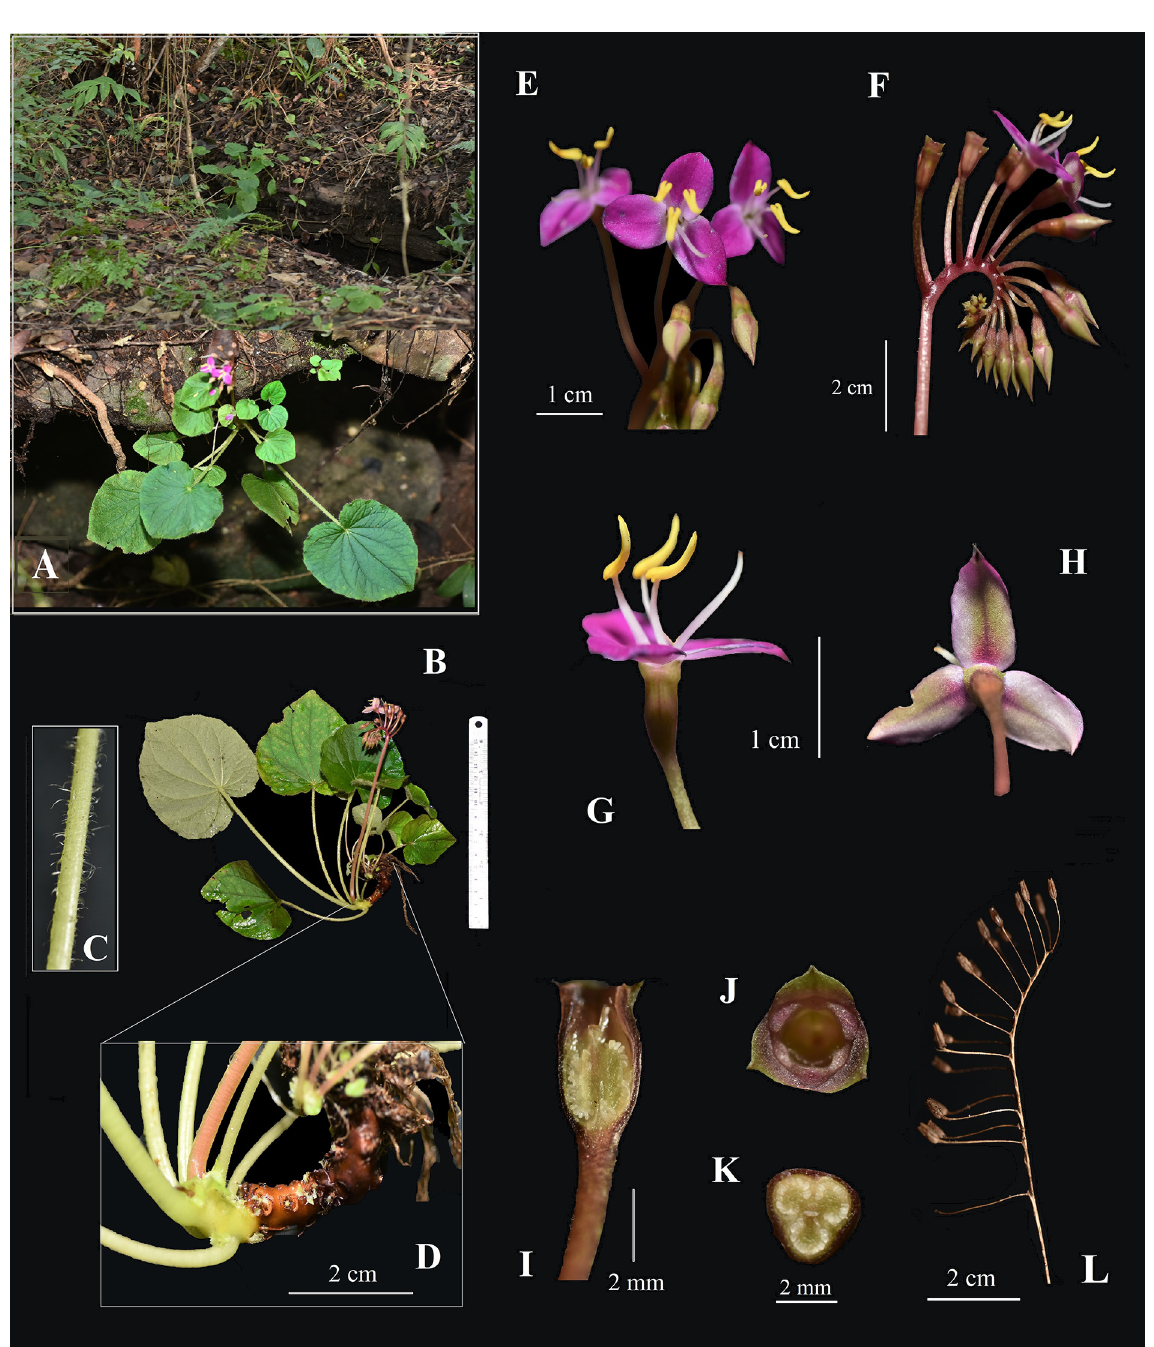
Fig. 4. Sonerila souvannii Phonep. & Soulad. sp. nov. A . Habitat (on sandstone rock). B . Habit. C . Petiole densely covered with villous hairs. D . Rhizome and stem with rudimentary leaves. E . Flowers. F . Inflorescence (scorpioid cyme). G . Lateral view of flower. H . Back view of flower. I . Longitudinal section of fruit. J . Top view of fruit. K . Cross section of fruit. L . Infructescence of the last season. Photos by P. Phonepaseuth on 12 September